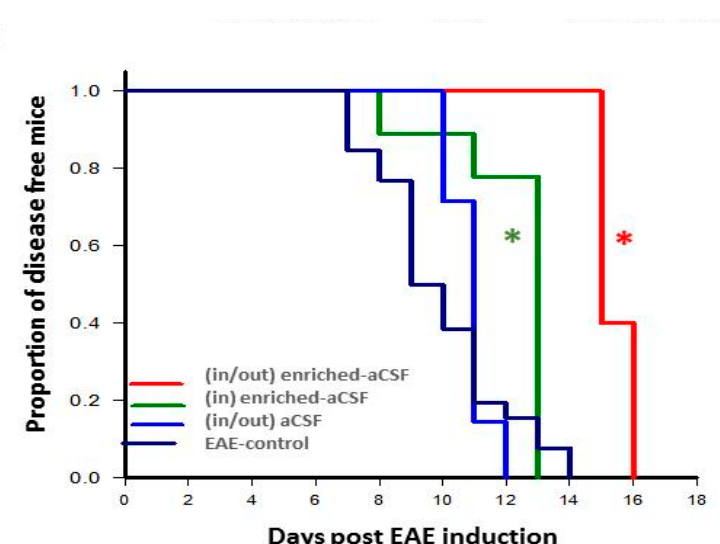
Figure 5. Prolonged amelioration of EAE clinical symptoms during prolonged CSF exchange therapy: (in/out) enriched-aCSF protocol was more effective than (in) enriched-aCSF and (in/out) aCSF. Prolonged CSF exchange therapy, which was delivered during days 6–22 after disease induction (performed 5 times a week for 2 weeks) was performed, comparing 3 protocols: (in/out) enriched-aCSF, (in) enriched-aCSF, and (in/out) aCSF (unenriched), vs. (untreated) EAE-control mice. Repeated ANOVA analysis showed a significant difference between the different treatment groups (f(2,24) = 9.59, p < 0.001)), with Tukey Post-hoc analysis showing significant differences between the control EAE-mice and each treatment group ( p < 0.001, p = 0.035 and p = 0.001 for (in/out) enriched-aCSF, (in) enriched-aCSF, and (in/out) aCSF, respectively). ( a ) While the (in/out) enriched-aCSF mice showed a significant lower average score relative to control-EAE during all days of symptoms follow-up ( p = 0.005, p = 0.013, p < 0.001, p = 0.004, p = 0.001, p = 0.005 for days 11, 12, 14, 15, 17, 18 post induction, respectively, red asterisks), the (in) enriched-aCSF mice showed a significant lower average score ( p > 0.001, p = 0.01, p = 0.002 only at days 11, 12, 14, respectively, green asterisks; and the (in/out) aCSF mice showed a significant lower score ( p < 0.001, p = 0.01, p = 0.019 only at days 14, 15, 17, with a similar trend, p = 0.066, also at day 18, respectively, light blue asterisks. A lower average score of (in/out) enriched-aCSF-mice was demonstrated relative to that of (in) enriched-aCSF-mice at days 15 and 17 ( p = 0.06 and p = 0.03, respectively); ( b ) A significant difference in the average cumulative score between the groups was noticed (one-way ANOVA (f(3,44) = 11.04, p < 0.001)), with further analysis with Tukey Post-hoc showing that the (in/out) enriched-aCSF-mice and the (in/out) aCSF had lower scores compared to EAE-controls ( p < 0.001, p = 0.008, respectively), with (in/out) enriched-aCSF-mice having lower scores than the (in) enriched-aCSF-mice ( p = 0.004), with comparable scores of the (in) enriched-aCSF-mice and the (in/out) aCSF-mice; ( c ) A significant difference in average maximal score between the groups was noticed (one-way ANOVA (f(3,48) = 5.55, p = 0.003)), with further analysis with Tukey Post-hoc showing that the (in/out) enriched-aCSF-mice had a lower score compared to control and (in) enriched-aCSF ( p = 0.002, p = 0.02, respectively), with comparable scores of the (in) enriched-aCSF-mice and the (in/out) aCSF-mice; ( d ) Kaplan Meier analysis revealed significant less EAE disease-free mice among the different groups (Log-Rank Test: p < 0.001), with each pair of groups showing significant differences ((in/out) enriched-aCSF-mice vs. EAE-control, (in) enriched-aCSF-mice and (in/out) aCSF-mice: p = 0.000387, 0.00507 and 0.0041, respectively; (in) enriched-aCSF-mice vs. EAE-control and (in/out) aCSF-mice: p = 0.0415 and 0.0141, respectively), but not (in/out) aCSF-mice vs EAE-control. The median values for the 50% chances to stay free of disease symptoms were 15, 13, 11, and 9 days for the (in/out) enriched-aCSF-mice, (in) enriched-aCSF-mice, (in/out) aCSF-mice and EAE-control, respectively (asterisks present comparison of a specific group with